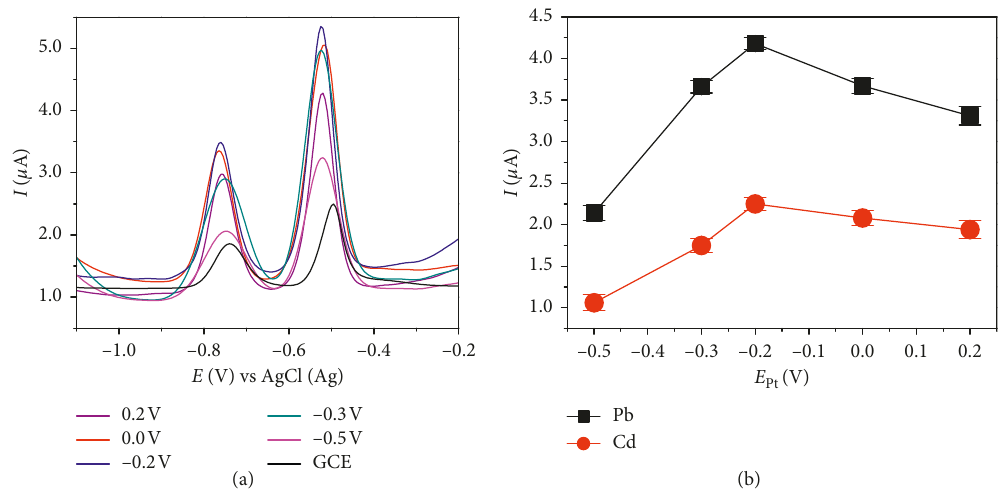
F IGURE 7: DPASVs at GCE and PtNFs/GCE prepared at different electrodeposition potentials (EPt) in acetate buffer solution pH 4.5 containing 10 µ g · L − 1 · Pb 2+ and Cd 2+ (a); the influence of EPt of electrode fabrication on peak current of Pb 2+ and Cd 2+ (b).